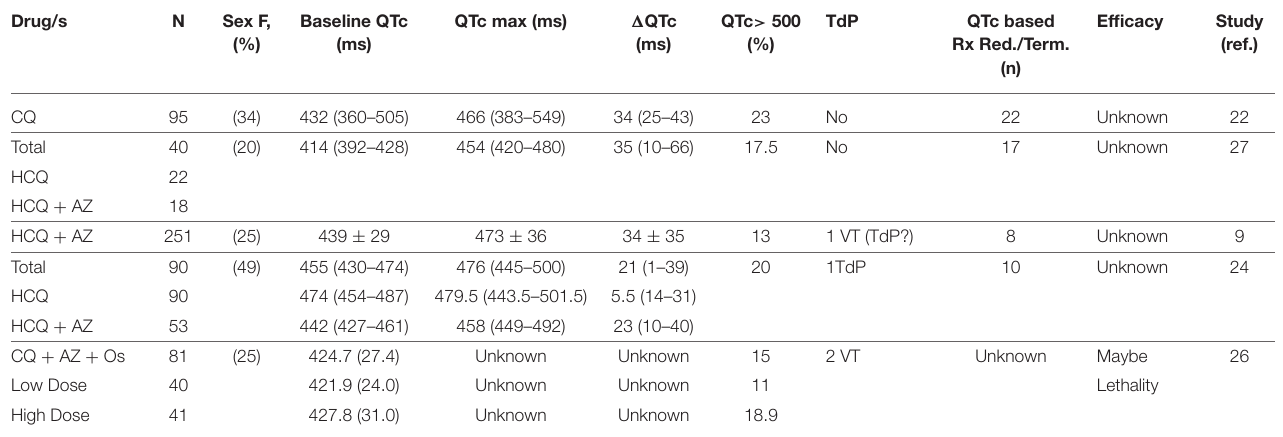
TABLE 1 | Corrected QT (QTc) Interval prolongation review from different